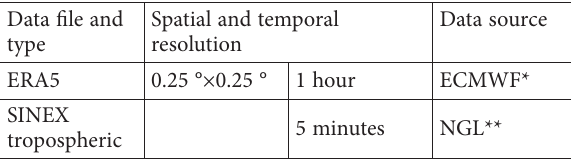
Table 2. Characteristics of data set used for the study Data file and type